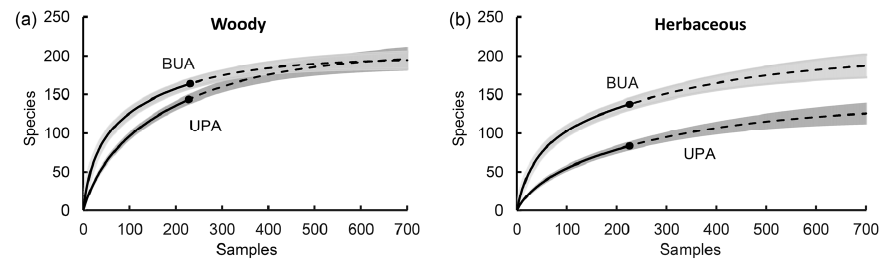
Figure 3. Sample-based rarefaction and extrapolation for reference samples for ( a ) woody plant species and ( b ) herbaceous plant species from the built-up area (BUA) and the urban planning area (UPA) under the Bernoulli product model, with 95% unconditional confidence intervals.